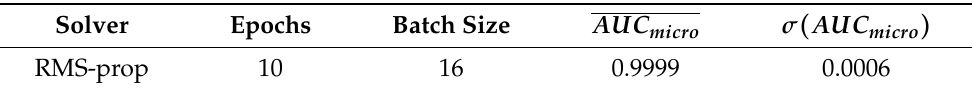
Table 6. The AlexNet architecture with the highest plane recognition